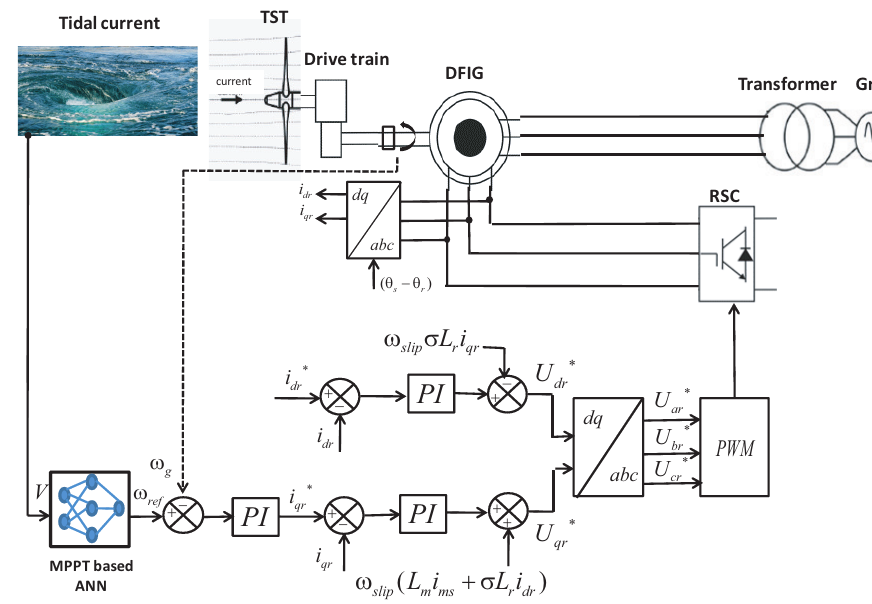
Figure 10. Stator flux oriented control strategy for the